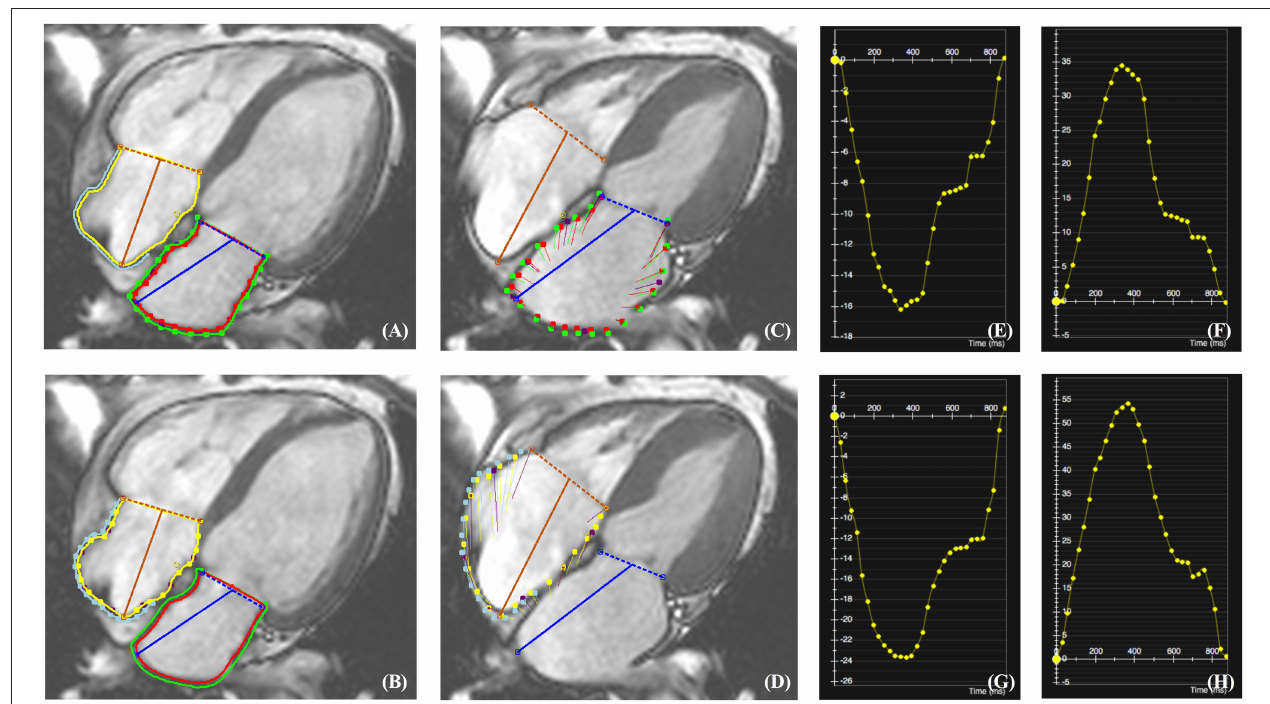
FIGURE 1 | CMR-TT analysis of LA and RAFW radial and longitudinal strains (RS and LS). The location of mitral and tricuspid valves as well as the delineation of LA and RAFW endo- and epicardial borders were performed at end-diastole (A,B) . After the completion of tracking, the myocardial deformation at end-systole was indicated by red and green lines for LA (C) , and yellow and blue lines for RAFW (D) . The strain-time curves of LARS (E) , LALS (F) , RAFW-RS (G) , and RAFW-LS (H) were generated directly by CMR-TT.